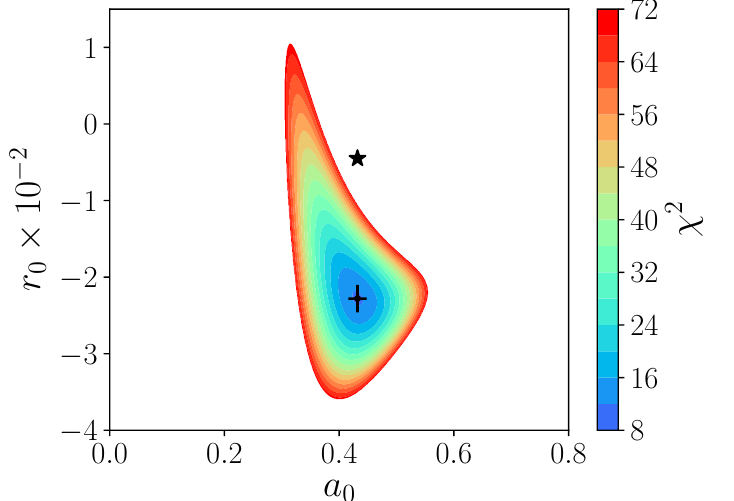
Figure 12. χ 2 heat map that corresponds to the ∆ E 2 -fit to order L − 6 taking both EC and RC into account. The fit interval is [9 , 24] , and a 0 is fixed to 0.432. The black data point with error bars marks the corresponding fit result for r 0 , cf. table 5. The black star corresponds to the perturbative